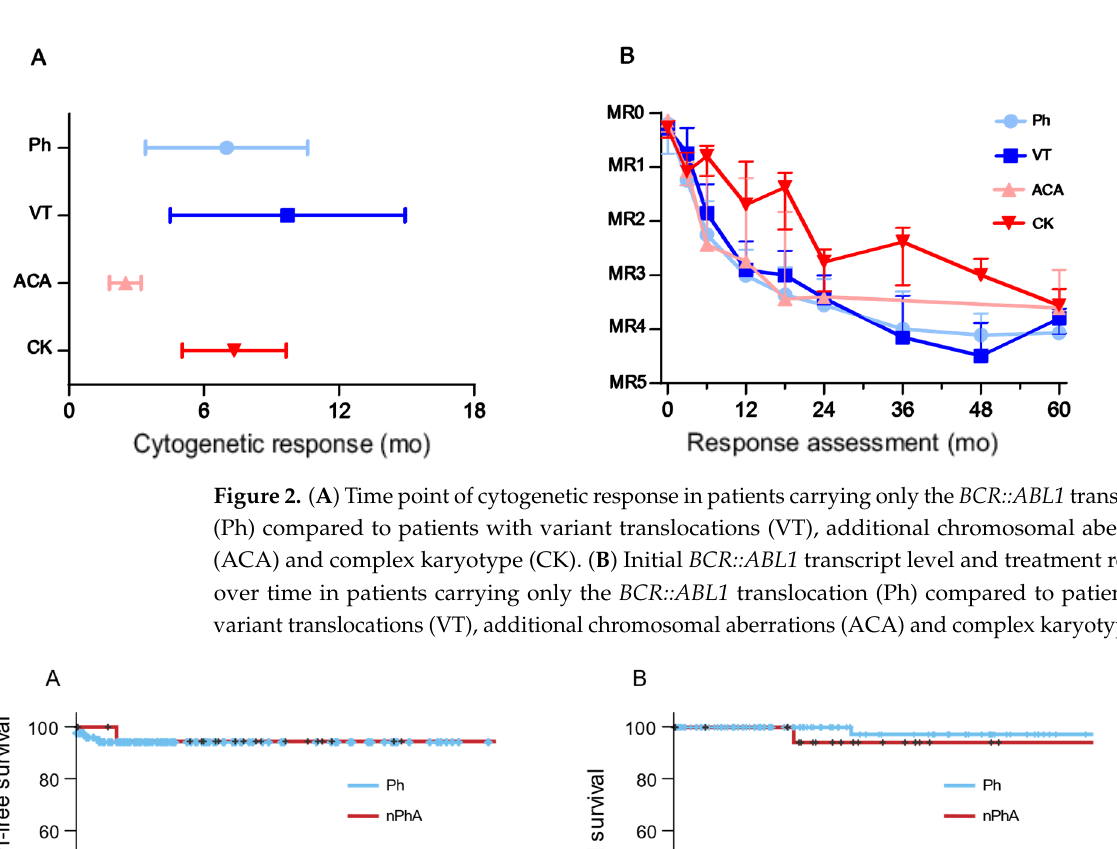
Figure 2. ( A ) Time point of cytogenetic response in patients carrying only the BCR::ABL1 transloca- tion (Ph) compared to patients with variant translocations (VT), additional chromosomal aberra- tions (ACA) and complex karyotype (CK). ( B ) Initial BCR::ABL1 transcript level and treatment re- sponse over time in patients carrying only the BCR::ABL1 translocation (Ph) compared to patients with variant translocations (VT), additional chromosomal aberrations (ACA) and complex karyo- type (CK).